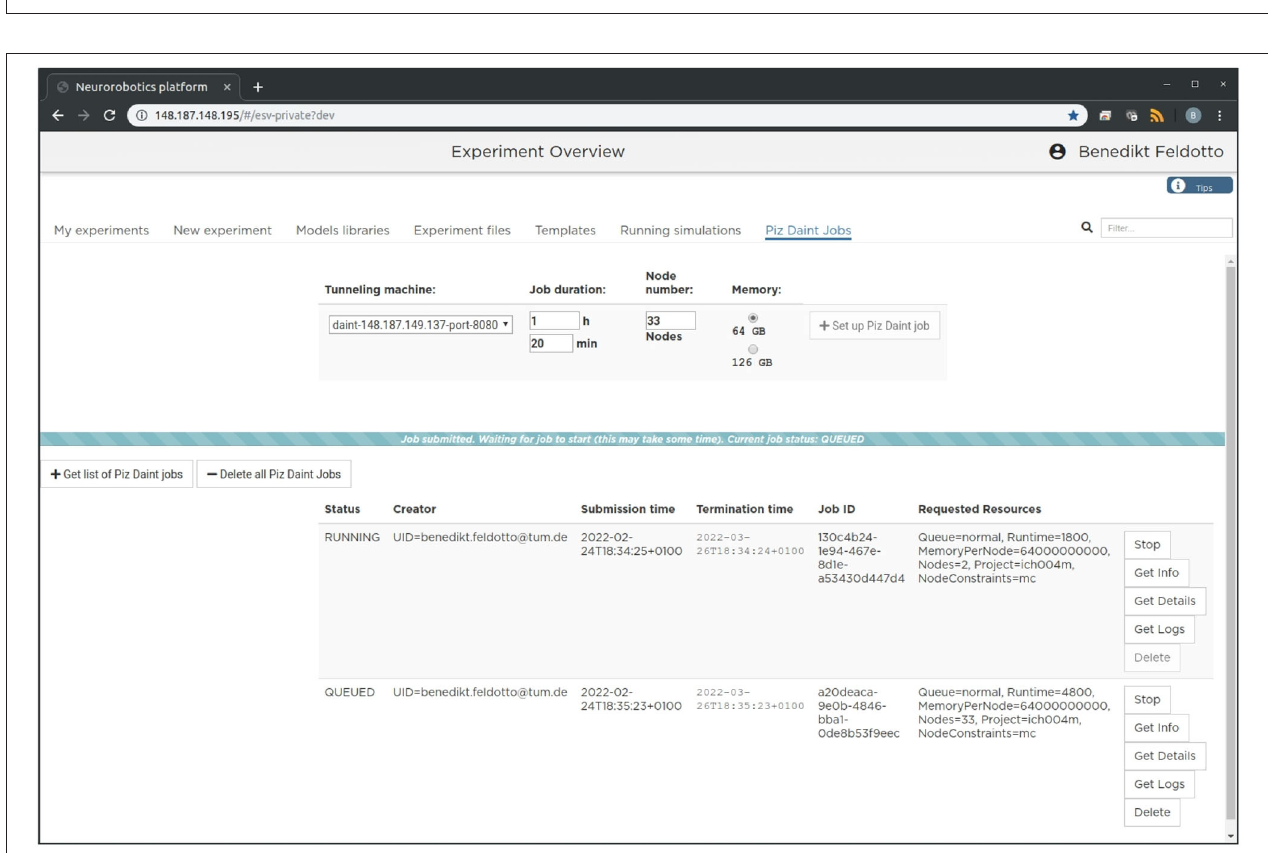
FIGURE 2 | Graphical user interface. The large-scale simulation setup on HPC resources can be managed, accessed and controlled via a standard browser. We implemented a dedicated tab in the Neurorobotics Platform frontend that lets users parametrize supercomputing jobs and manage allocated resources. A new compute job running the NRP backend instance with distributed NEST can be requested and started with a single click from this frontend.